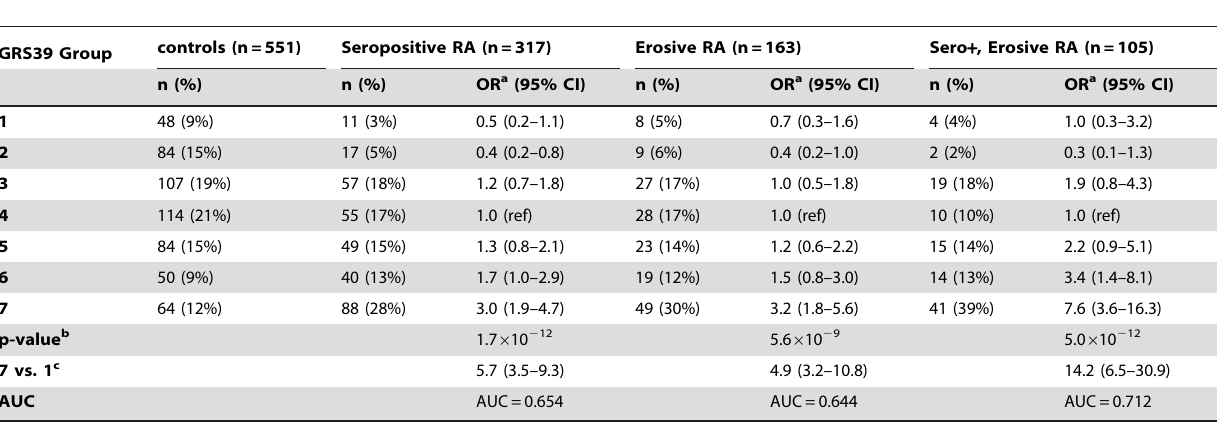
Table 2. Weighted GRS groups and odd ratios of seronegative, Seropositive, Erosive and Seropositive/Erosive RA in NHS.